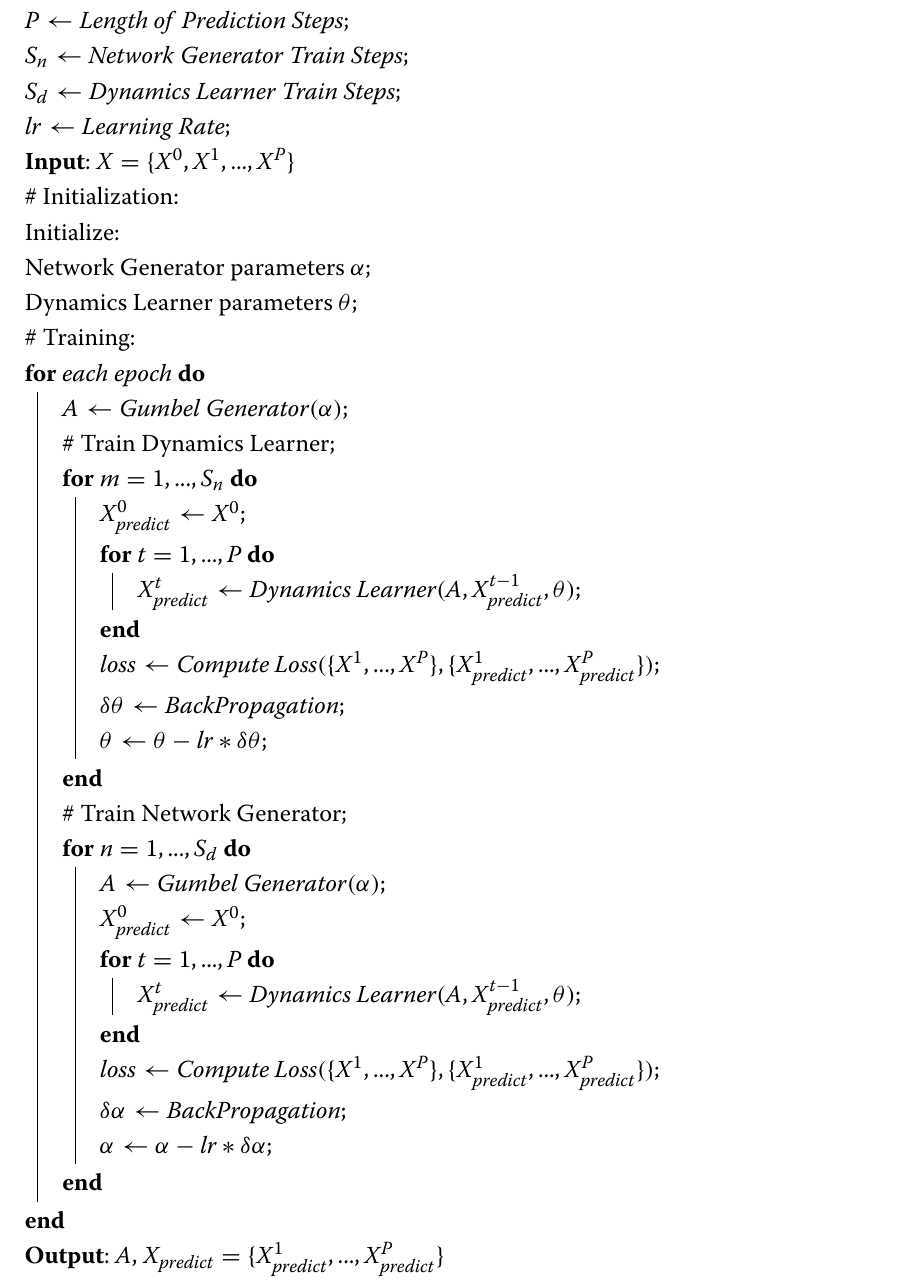
Algorithm 1: Gumbel Graph Network,